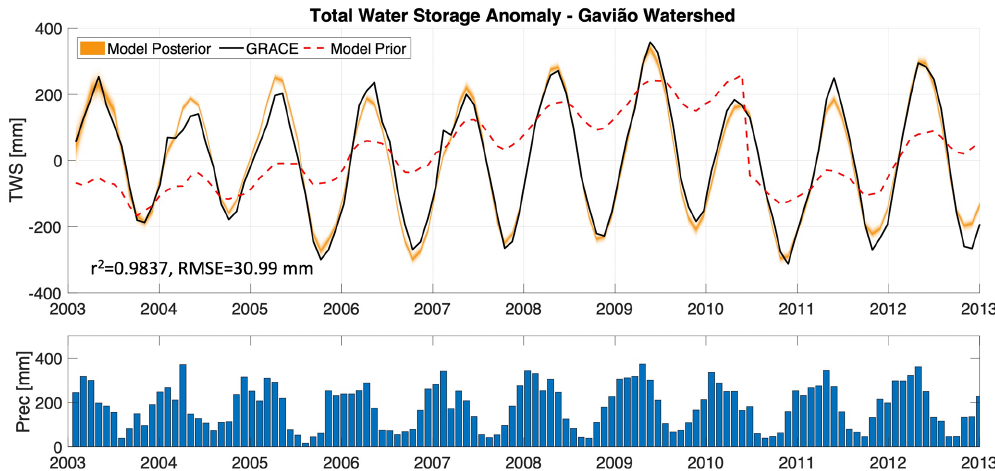
Figure 4. Monthly total water storage (TWS) anomaly estimates from satellite data (GRACE TWS), the prior simulation from the model, and the data-constrained version of the model simulations for the Gavião watershed. GRACE-informed posterior ranges of the model-simulated TWS are shown here in the orange envelopes. Precipitation values used to drive the model are shown to indicate the seasonal cycle.